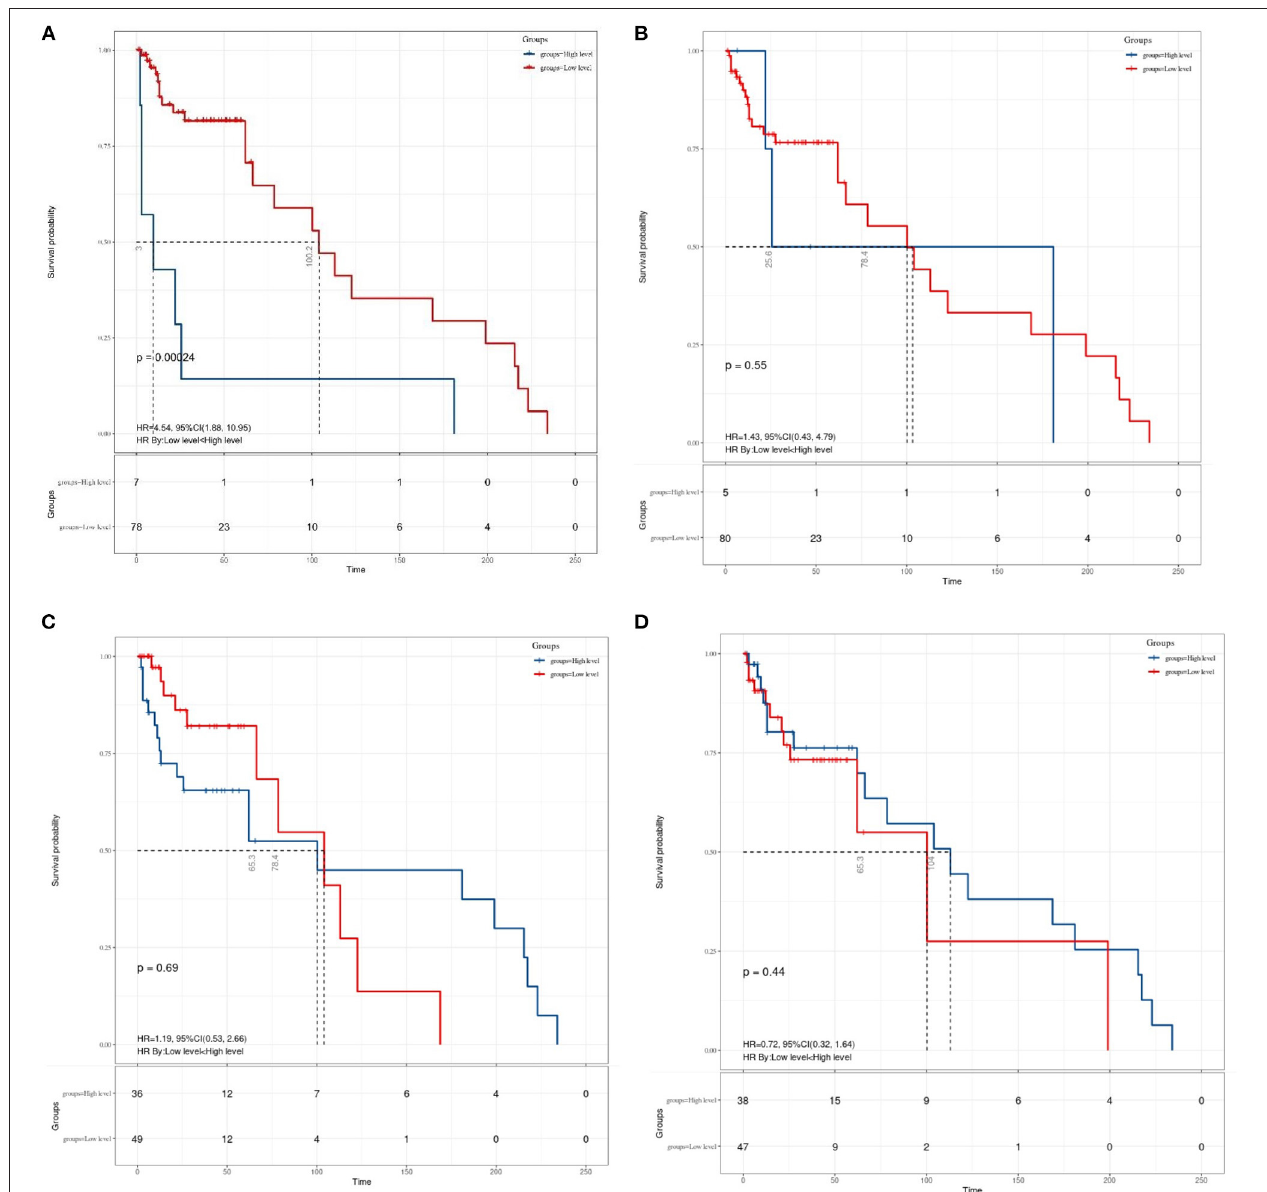
FIGURE 3 | The Kaplan–Meier survival curves for OS according to (A) SII, (B) NLR, (C) MLR, and (D) PNI in patients aged ≤ 18 years with medulloblastoma. SII, systemic immune-inflammation index; NLR, neutrophil–lymphocyte ratio; MLR, monocyte–lymphocyte ratio; PNI, prognostic nutritional